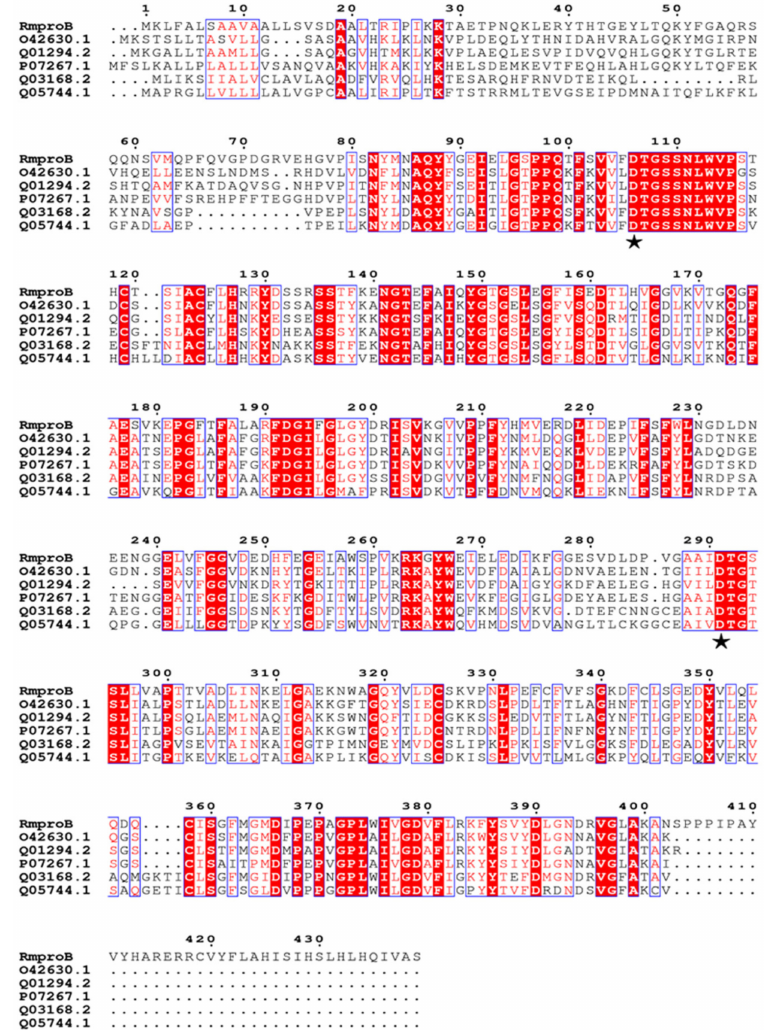
Figure 1. Multiple amino acid sequence alignment of RmproB with other A1 family aspartic proteases. RmproB was the aspartic protease from R. miehei in this study. The sequences, O42630.1 ( Aspergillus fumigatus ), Q01294.2 ( Neurospora crassa ), P07267.1 ( Saccharomyces cerevisiae ), Q03168.2 ( Aedes aegypti ), and Q05744.1 ( Gallus gallus ) were downloaded from the NCBI protein database. Identical residues are shaded in red, and conserved residues are shown in blue boxes. The conversed catalytic residues are marked with